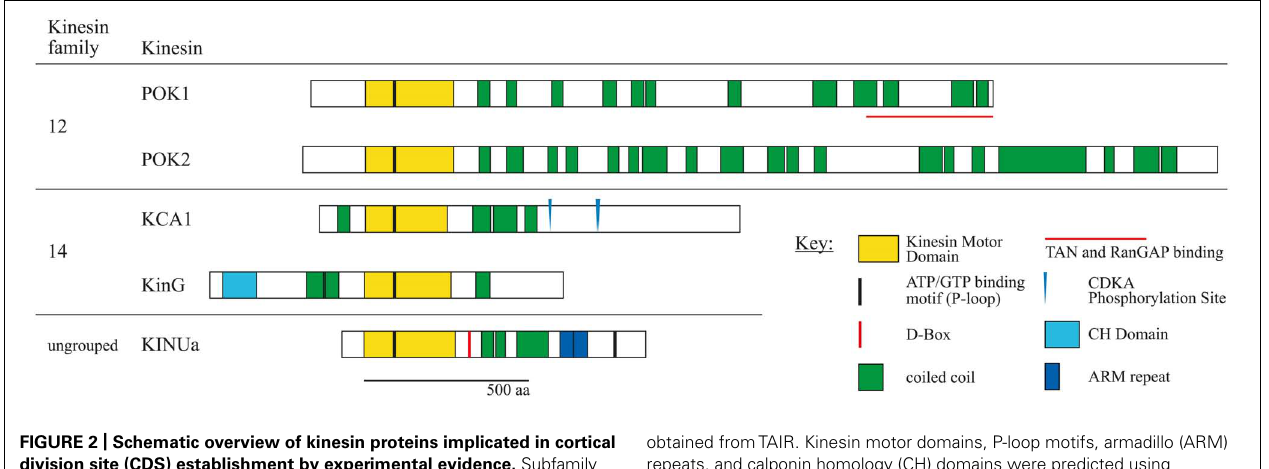
FIGURE 2 | Schematic overview of kinesin proteins implicated in cortical division site (CDS) establishment by experimental evidence. Subfamily affiliations are according to the nomenclature (Lawrence etal., 2004). Proteins were co-aligned with respect to the P-loop motifs within the motor domain. Experimentally confirmed D-BOX motifs and CDKA phosphorylation sites are indicated. Amino acid sequences were